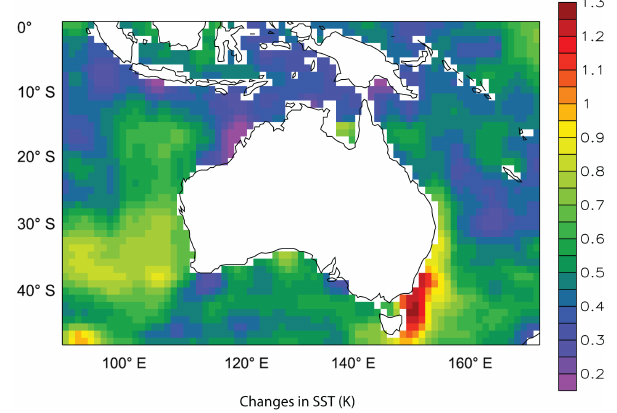
Figure 8. Annual mean 120-year differences (between 1990–2009 and 1870–1889) in